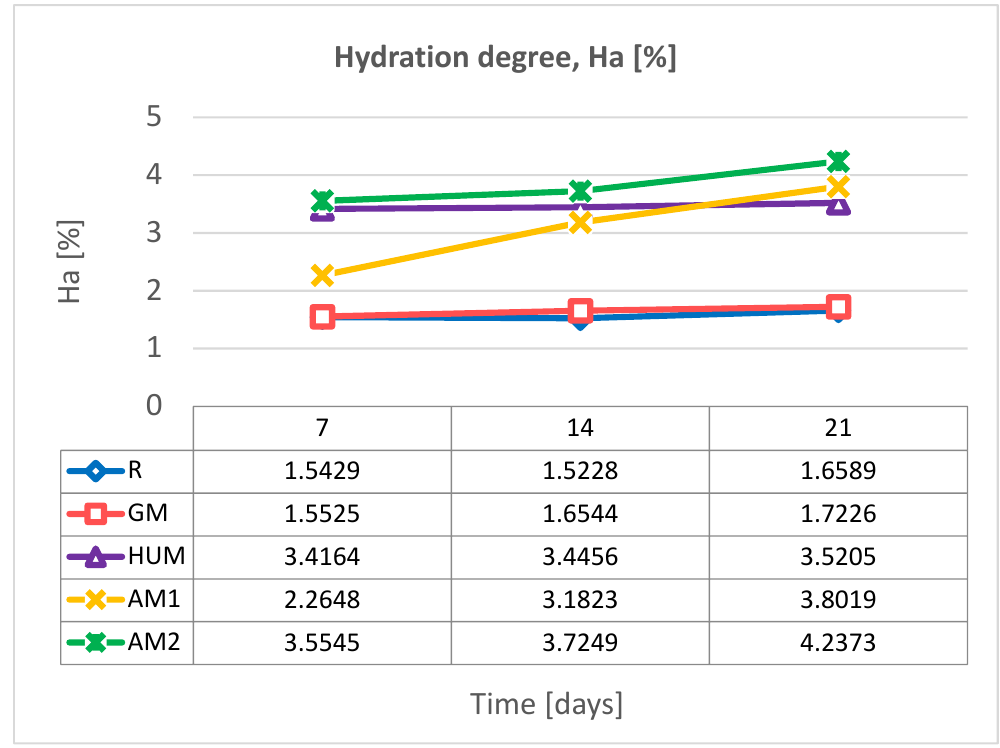
Figure 4. Variation of hydration degree over a period of 21 days in distilled water, at 37°C, for experimental bone cements samples .